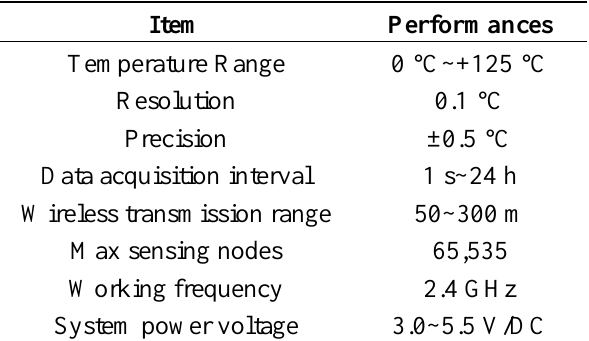
Table 1. Performances of